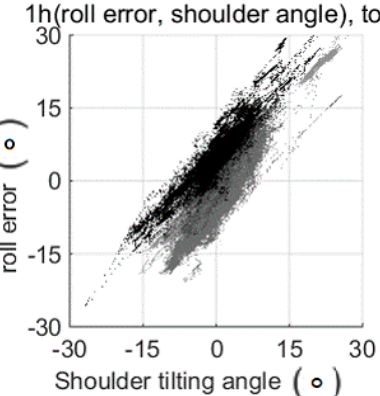
Figure 7. Correlation between the shoulder tilting angle from the spine and the roll estimation error. The shoulder angle and spine angle were measured by a camera, and the roll estimation error was calculated using the roll posture from the smart wear and the camera.